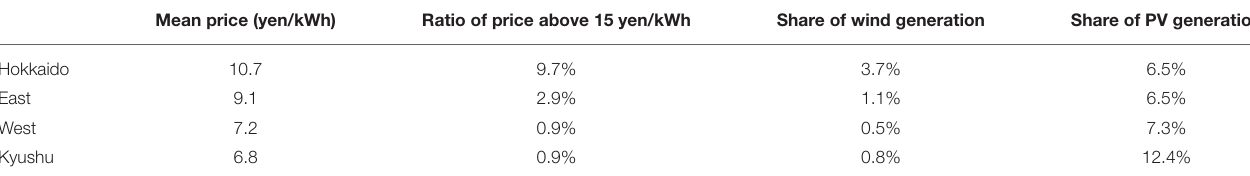
TABLE 4 | Descriptive statistics of the electricity prices and generation sources in each area during